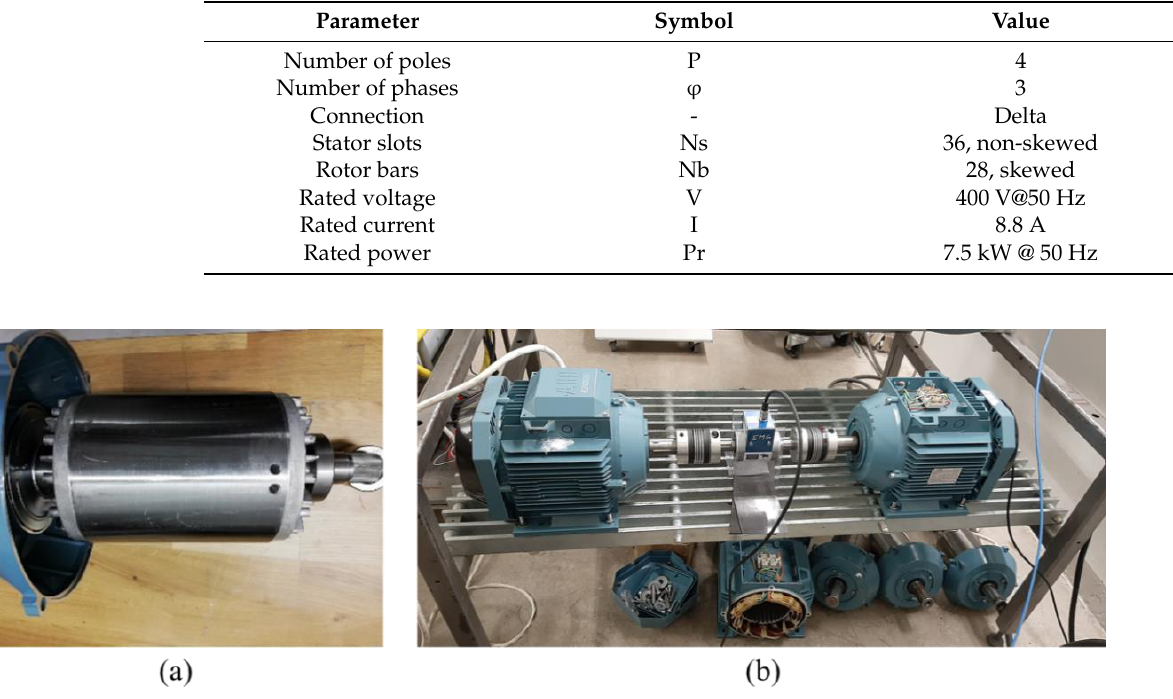
Figure 6. ( a ) The rotor with two broken bars. ( b ) The test bench with the loading motor on the right side and the test motor on the left side. Table 3. The setting of the industrial inverter to achieve the desired